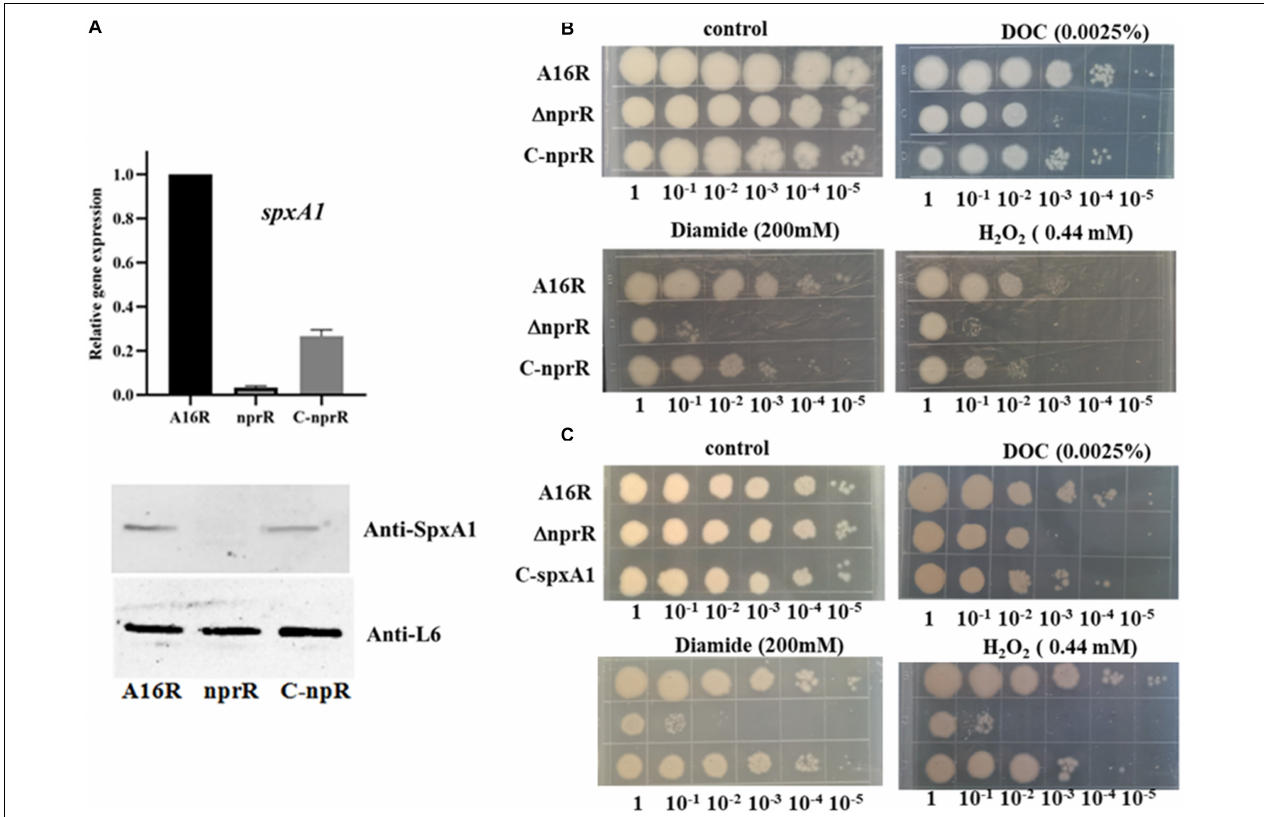
FIGURE 7 | Oxidative stress susceptibility analysis of the nprR deletion mutant. (A) qPCR and western blot analysis of spxA1 expression. (B,C) Strains were grown on LB media with or without 0.0025% DOC, 200 mmol/L diamide, or 0.44 mmol/L H 2 O 2 . Five microliters at the indicated dilutions were spotted onto LB agar (Materials and Methods). All experiments were performed at least three